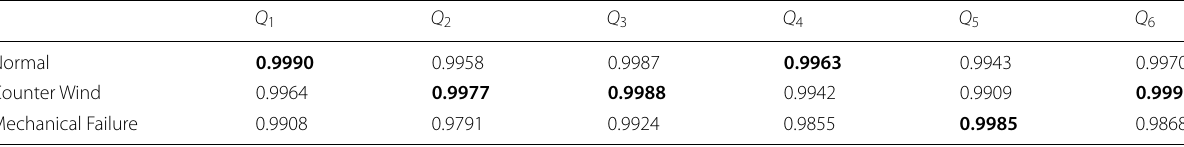
Table 5 The classifier p ( C | Q ) with equivalent to Cosine similarity between the trained model p ( C | T ) for each class and new samples maximum value of the cosine similarity for each sample is boldfaced Q